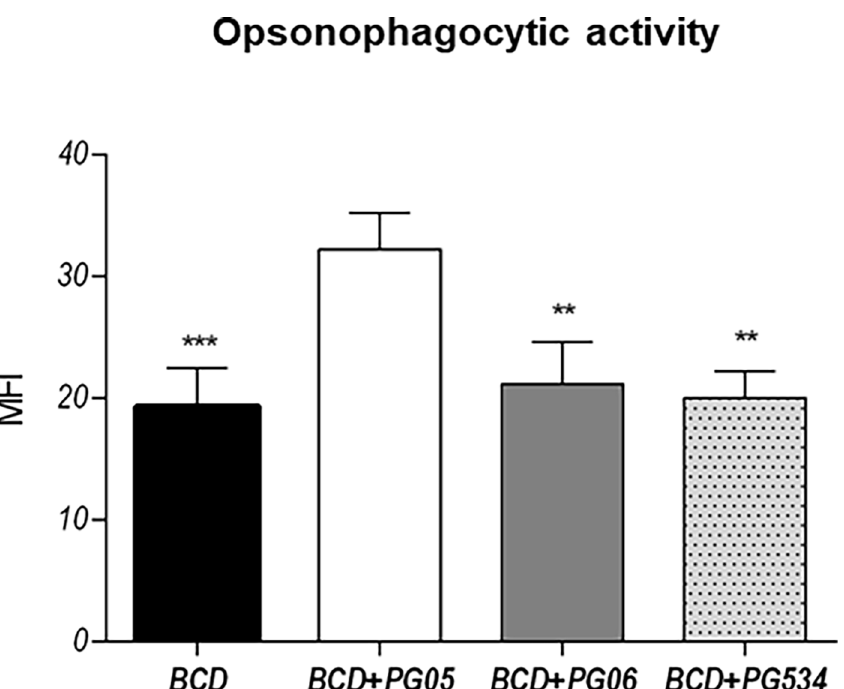
Fig 9. Effect of lactobacilli peptidoglycans on the opsonophagocytic activity of anti-pneumococcal antibodies after Streptococcuspneumoniae infection in malnourished mice. Immunocompromised-malnourished mice were replete for 7 days with a balanced conventional diet (BCD) or BCD supplemented with peptidoglycans from Lactobacillus rhamnosus CRL1505 (BCD+PG05), L . plantarum CRL1506 (BCD+PG06) or L . rhamnosus CRL534 (BCD +PG534), and then challenged with S . pneumoniae . The opsonophagocytic activity of antibodies were studied fifteen days after the pneumococcal challenge. Results represent data from three independent experiments. Results are expressed as mean ± SD. Asterisks represent statistical differences compared with BCD+PG05 group. (cid:3) p < 0.05, (cid:3)(cid:3) p < 0.005, (cid:3)(cid:3)(cid:3) p (cid:20) 0.001.